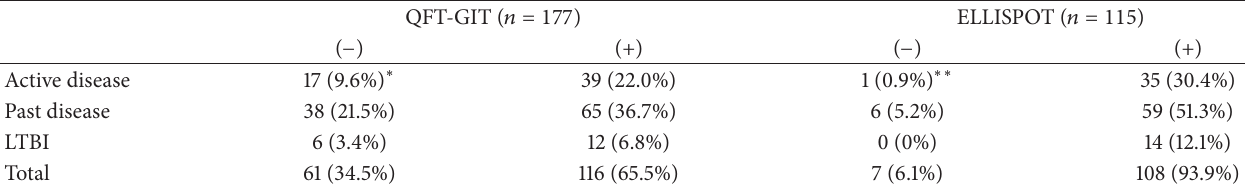
Table1:SensitivityofIGRAs.Patientsweredividedintothreecategories:activedisease,pastdisease,andlatentTBinfection(LTBI).QFT-GIT was conducted in 177 patients and ELISPOT in 115 patients.